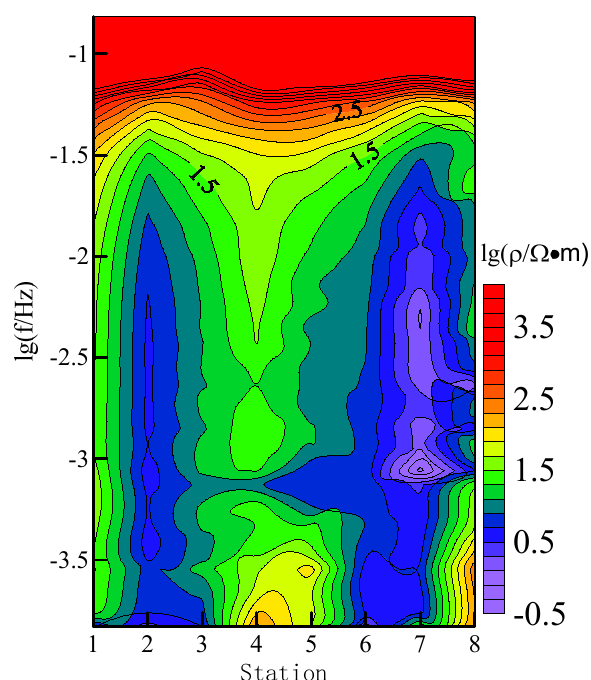
Figure 6. Equivalent apparent resistivity section